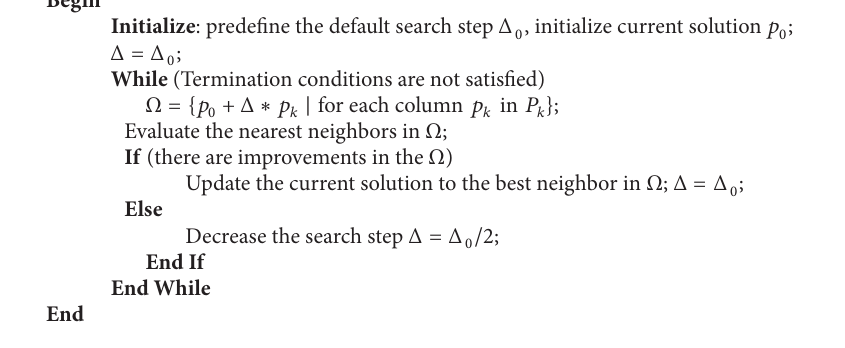
Algorithm 1: Pseudocode of pattern search for individual learning.